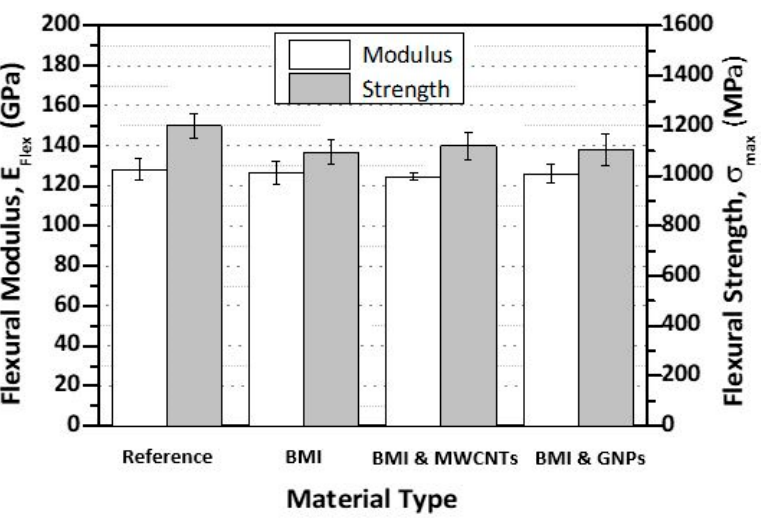
Figure 10. Bar chart diagram providing the flexural modulus (E Flex ) and flexural strength ( σ max ) values for the reference and the modified CFRPs (with pure BMI, BMI and MWCNTs, and BMI and GNPs).